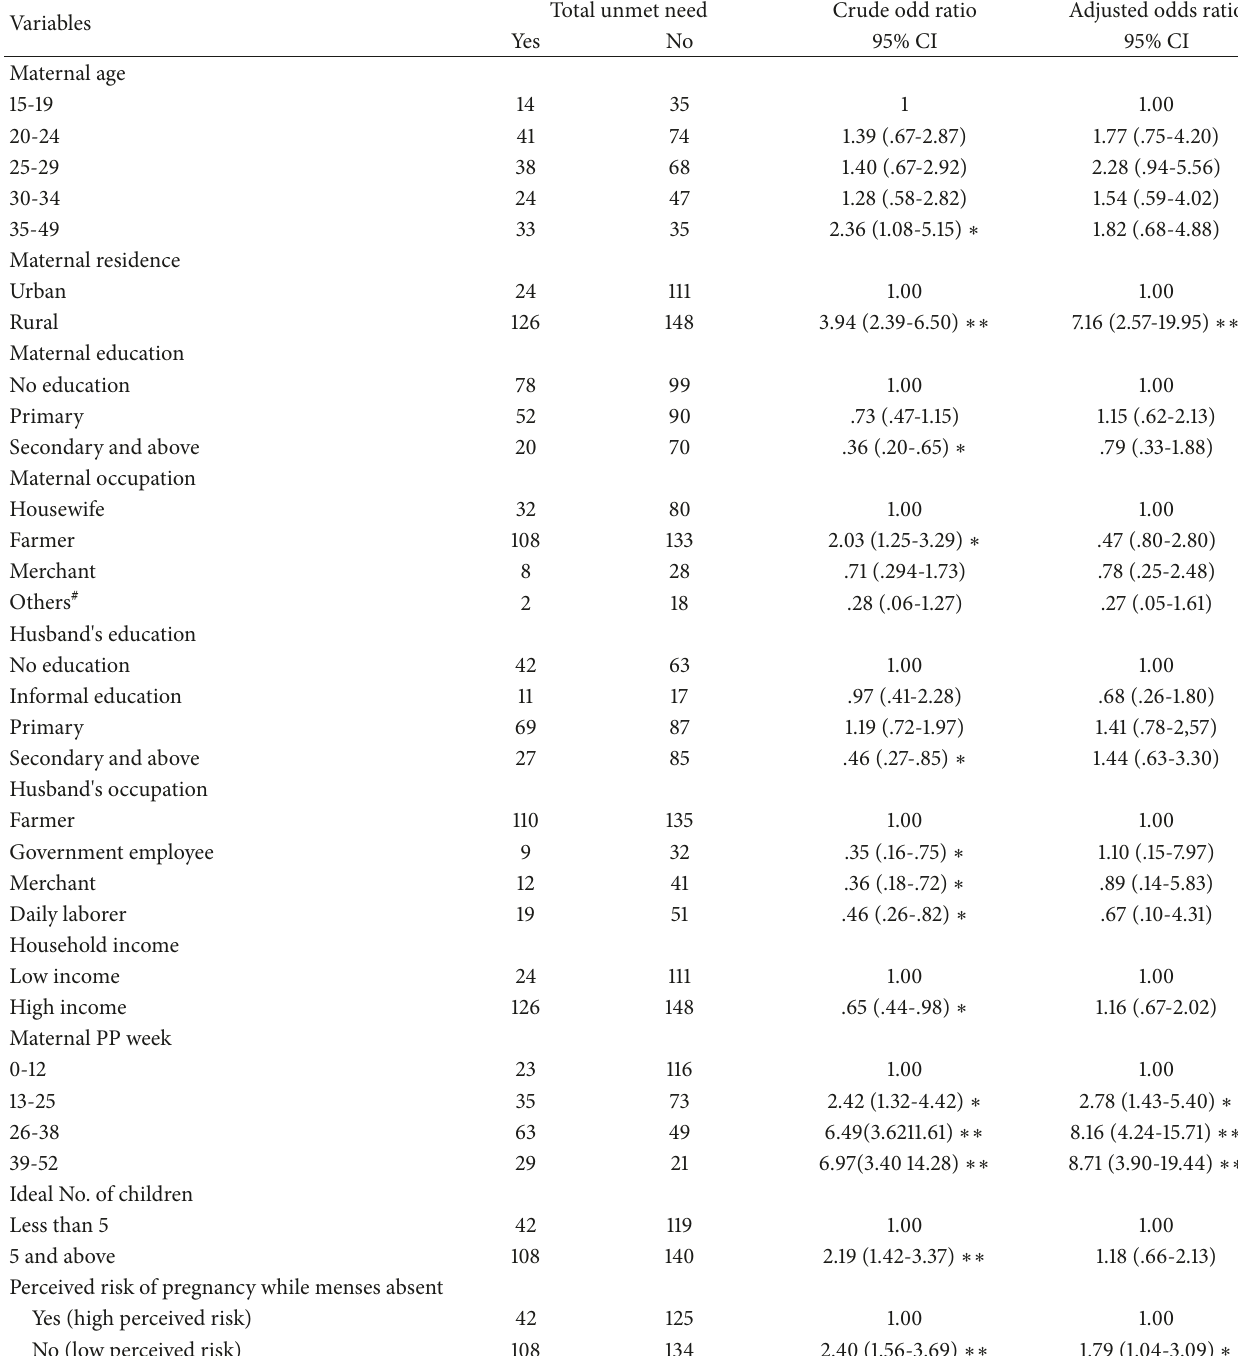
Table 4: The Association between unmet need for FP and different characteristics of women who are in EPPP in Tahtay Koraro Woreda, Tigray, Ethiopia,